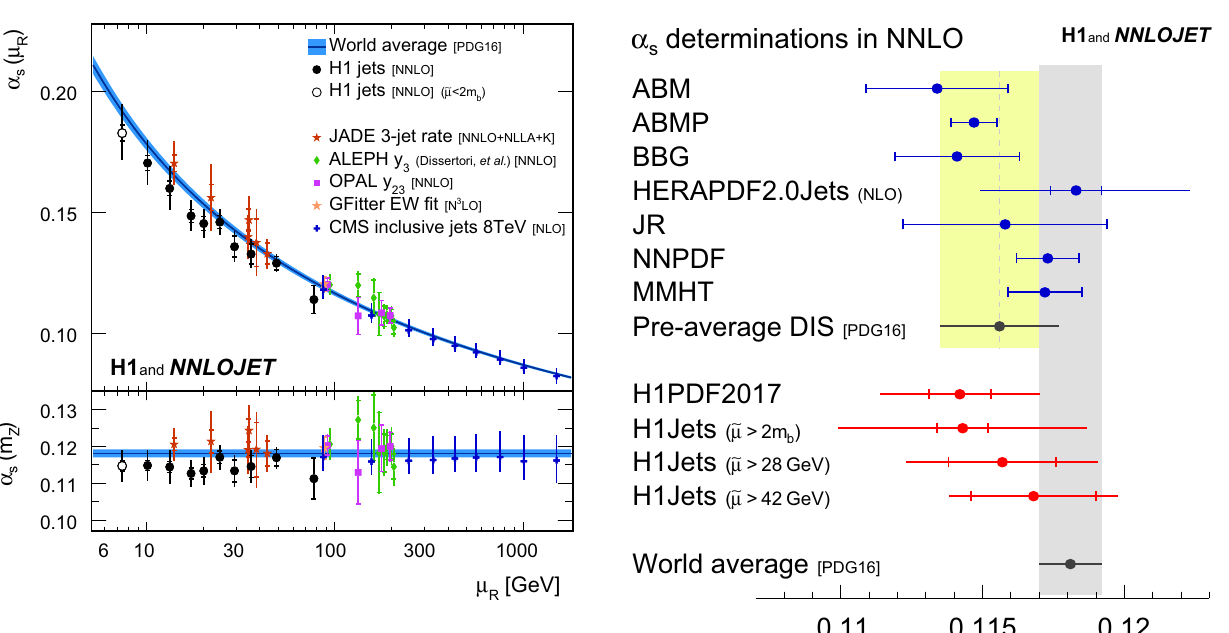
Fig. 14 Results for α s ( m Z ) and α s (μ R ) for fits to data points arranged in groups of similar μ R , compared to results from other experiments and processes. Further details can be found in the caption of Fig. 13 ment with NNPDF3.1 over a large range in x , whereas the gluondensityisconsistentwithNNPDF3.1onlyfor x > 0 . 01 and is significantly higher than NNPDF3.1 at lower x . This Table 6 Results of the PDF+ α s fit. The columns denote the resulting fit value, its uncertainty and the correlations to the other parameters Results for the PDF+ α s